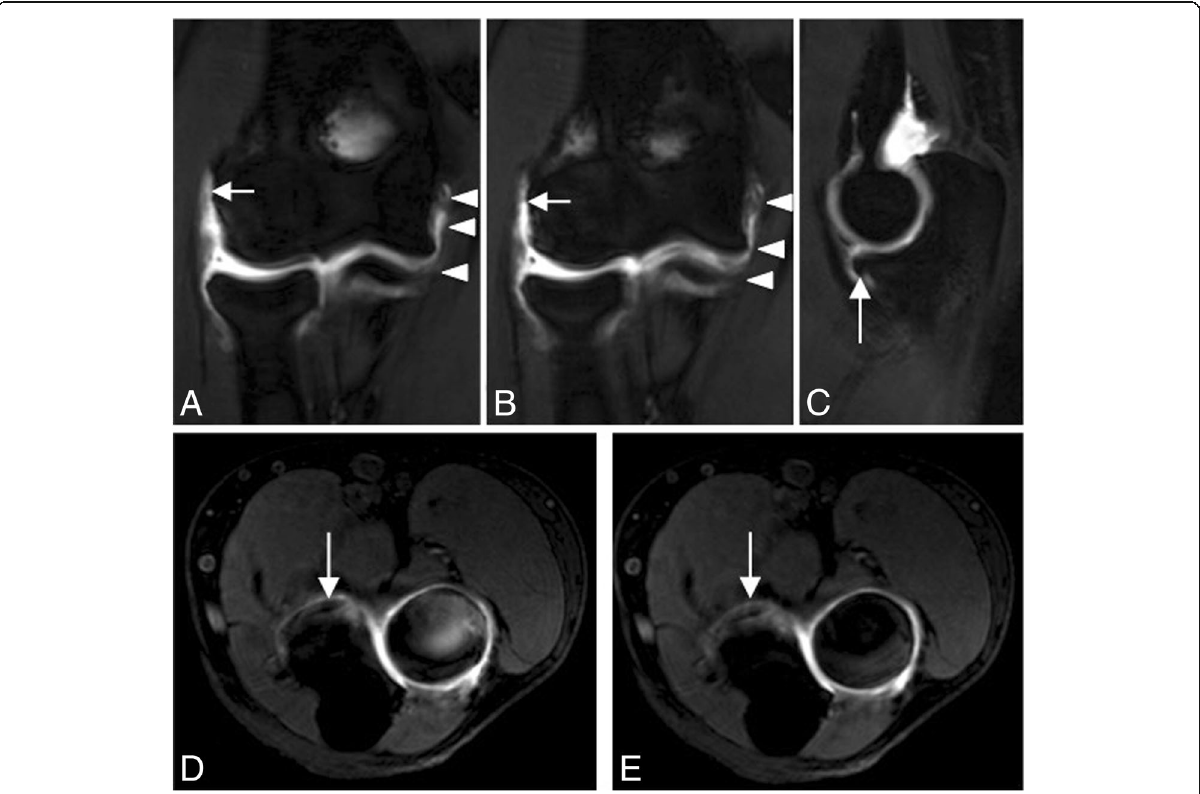
Fig. 27 Posterolateral rotatory instability, stage 3B. Consecutive coronal FS T1-weighted direct MR arthrographic images ( a , b ), sagittal FS T1- weighted direct MR arthrographic image ( c ), and consecutive axial FS T1-weighted direct MR arthrographic images ( d , e ) showing a proximal complete tear of the lateral ulnar collateral ligament and radial collateral ligament proper (white short arrows), diffuse partial-thickness tear of the anterior bundle of the medial collateral ligament complex (white arrowheads), and a non-displaced fracture of the coronoid process (long white